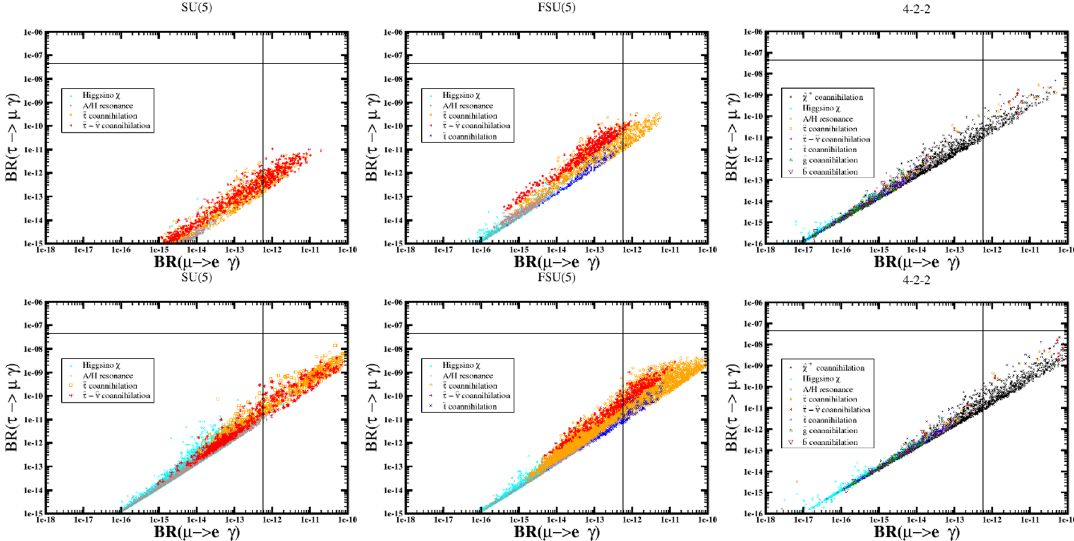
Figure 2 . Predictions for BR( (cid:28) ! (cid:22)(cid:13) ) and BR( (cid:22) ! e(cid:13) ) for (from left to right) the SU(5), FSU(5) and 4-2-2 models. The upper (lower) panels assume M N = 2 : 5 (cid:1) 10 12 ( M N = 10 13 GeV). The symbols correspond to classes of models representing the DM scenarios described in the text, which are indicated in the plot